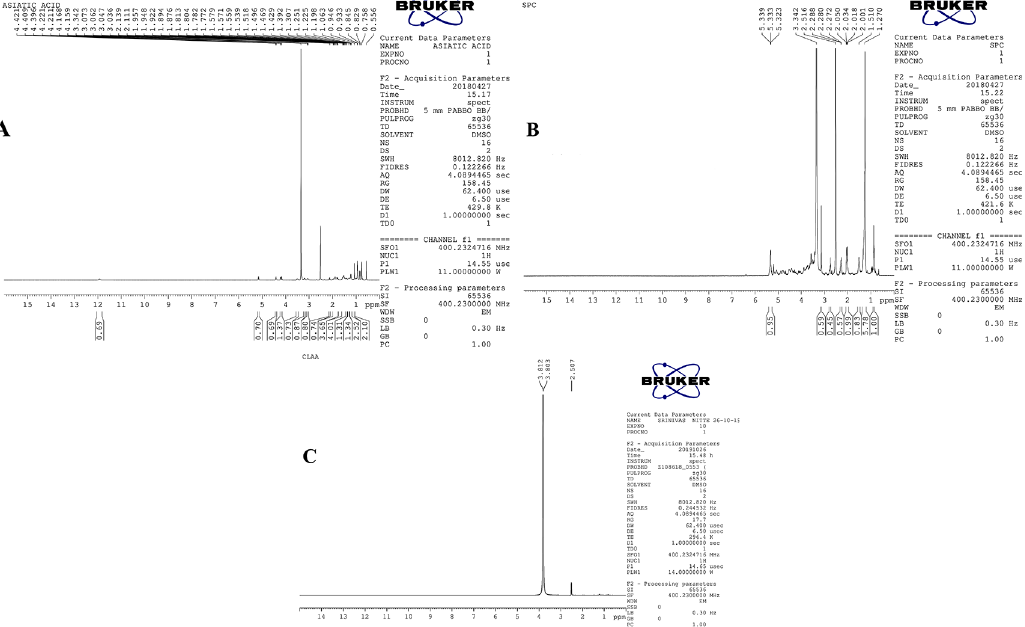
Figure 2. NMR of A) AA, B) SPC, C) Optimised